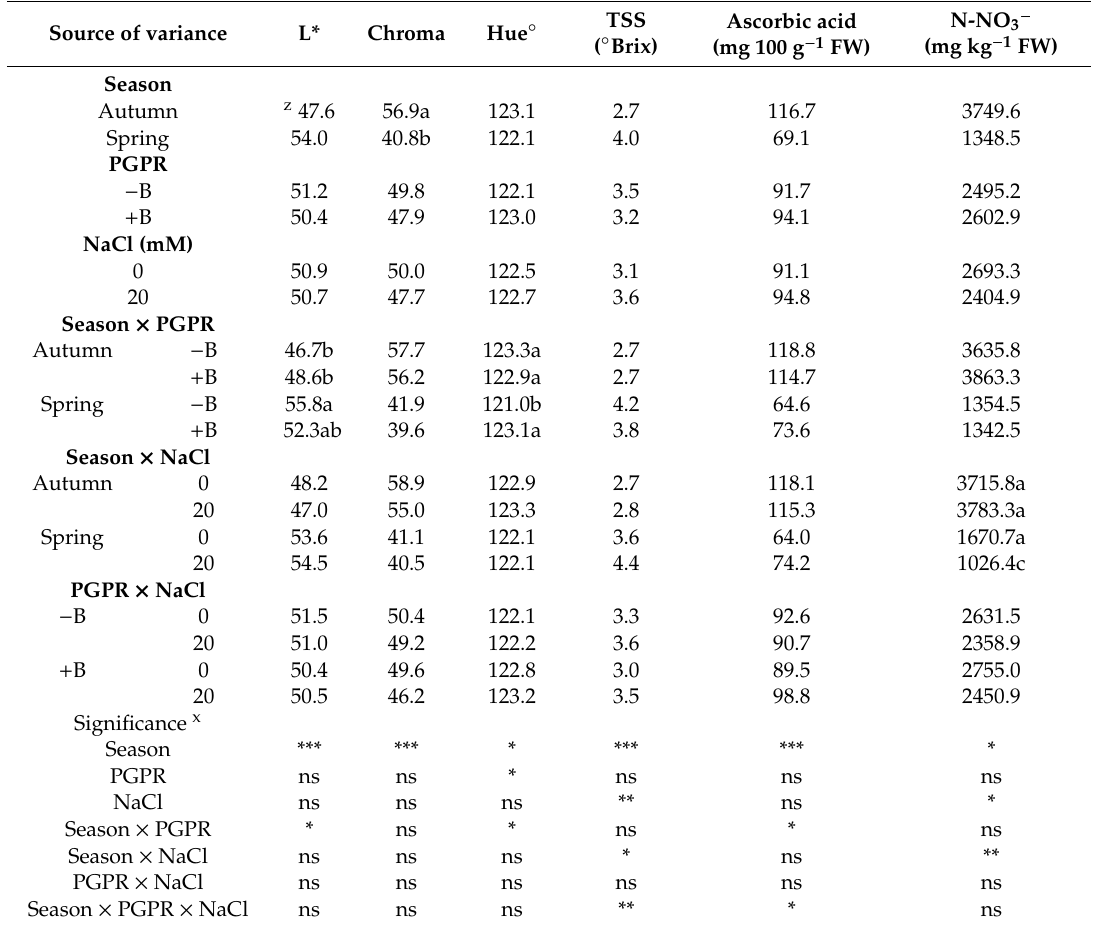
Table 4. Leaf color and chemical characteristics of leaf lettuce plants grown during autumn and spring in nutrient solutions containing di ff erent levels of NaCl and bacterial